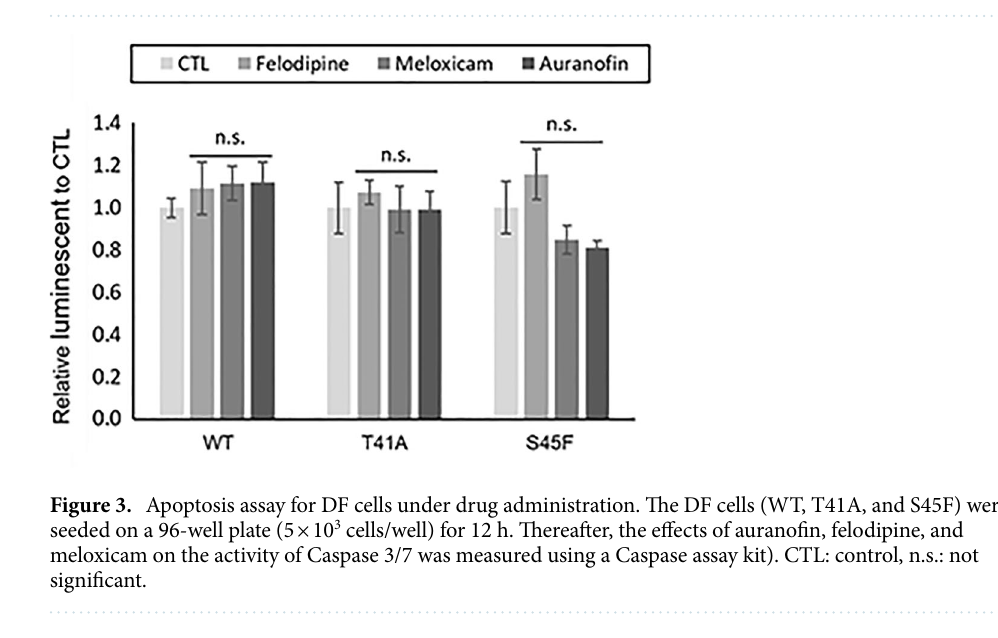
Figure 2. Effects of auranofin on DF cell proliferation. Inhibitory effects of auranofin on cell proliferation were evaluated with MTS assay. The DF cells were seeded on a 96-well plate (5 × 10 3 cells/well) for 12 h. Thereafter, the effects of auranofin at each concentration (0.2 to 10 µM) on cell proliferation was measured using the MTS assay kit after 24 h.